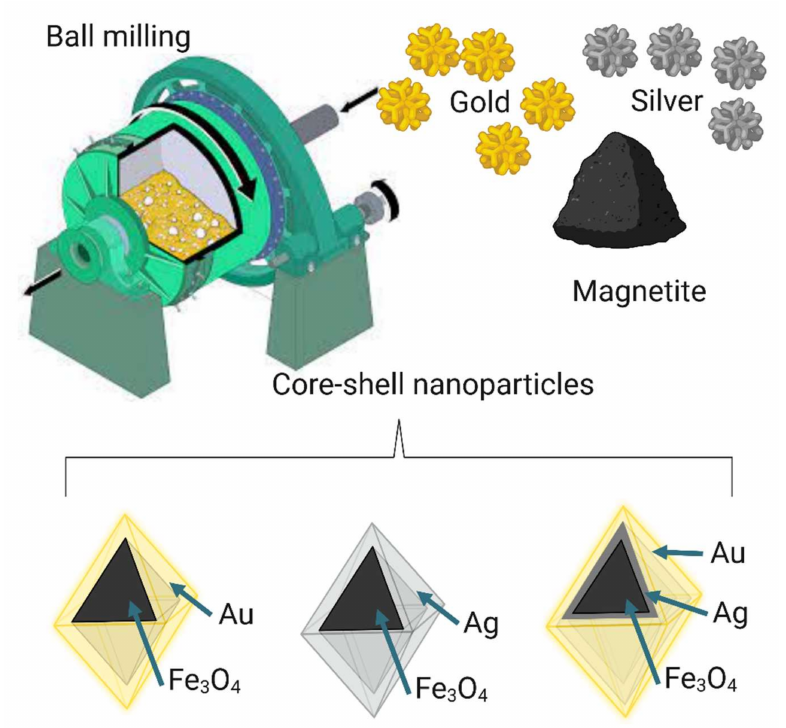
Figure 10. Schematic representation of large-scale solid-state synthesis of Fe 3 O 4 @M nanostructures (M = Au, Ag, or Au-Ag alloy). Image created with